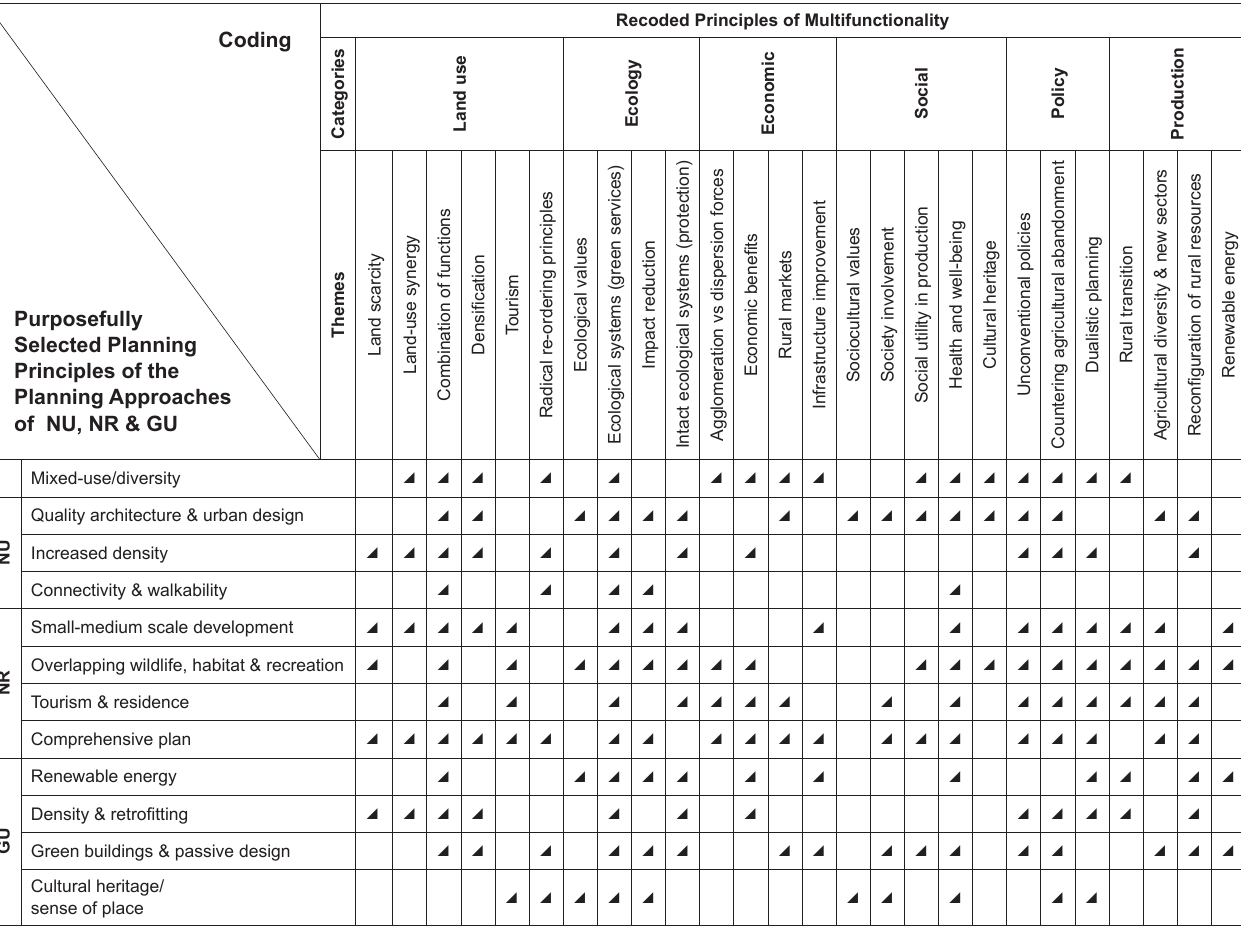
Table 1: Multifunctionality interface with planning principles of NU, NR and GU